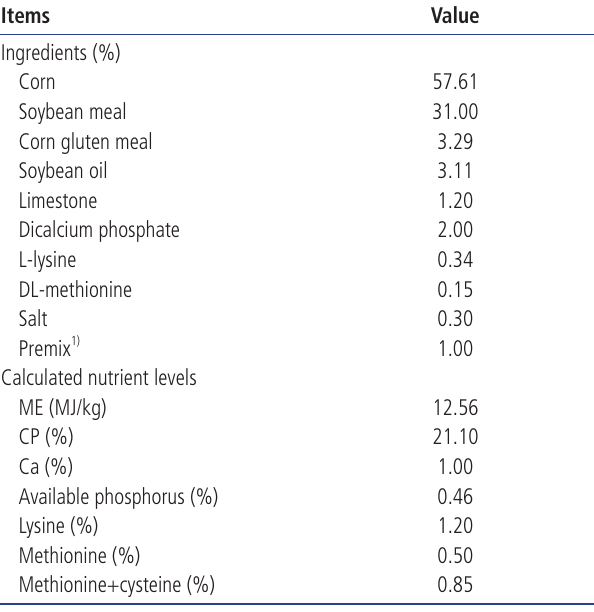
Table 1. The composition and nutrient levels of basal diets